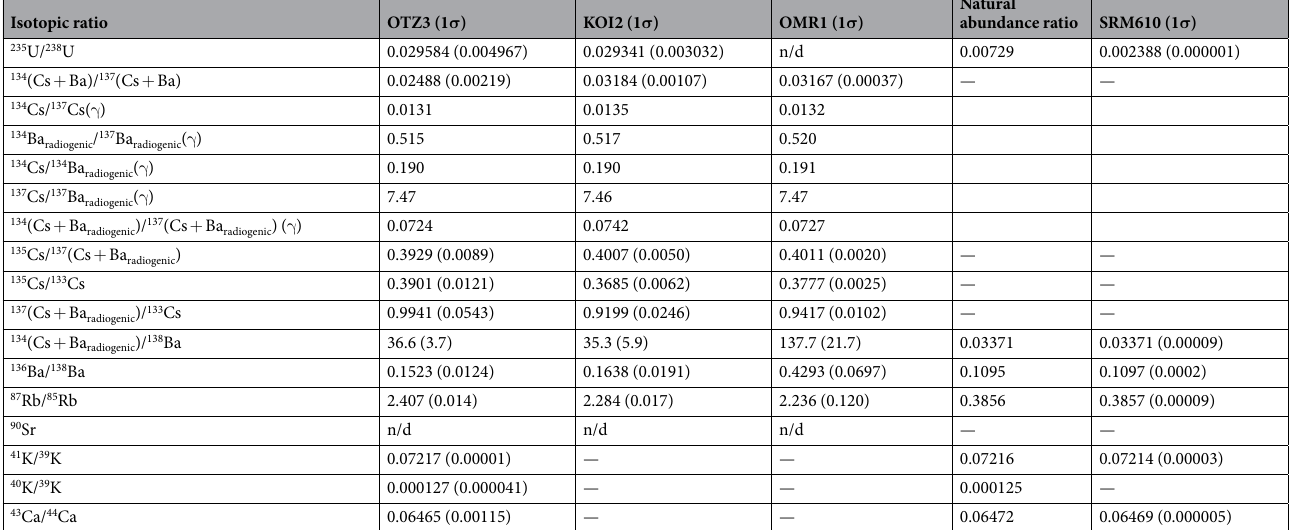
Table 2. Summary of isotope analysis for three CsMPs using SIMS and γ spectrometry. A NIST standard, SRM610, which contains depleted U, was also analyzed as a reference. Ten scans were conducted for each analytical spot on the CsMPs, meaning that the sequence of ten analyses represents a depth profile of the variation in the isotopic ratios; thus, SIMS analyses provide the isotope signatures inside the CsMPs. The average values are given in the table with the standard deviation calculated for the ten analyses and the standard deviations are given in the parenthesis as 1 σ . The isotopic ratios recalculated from the results of γ spectrometry are annotated as ( γ ). Conversion of radioactivity to isotopic ratio was conducted by decay-correcting to the time of SIMS analysis. n/d stands for not